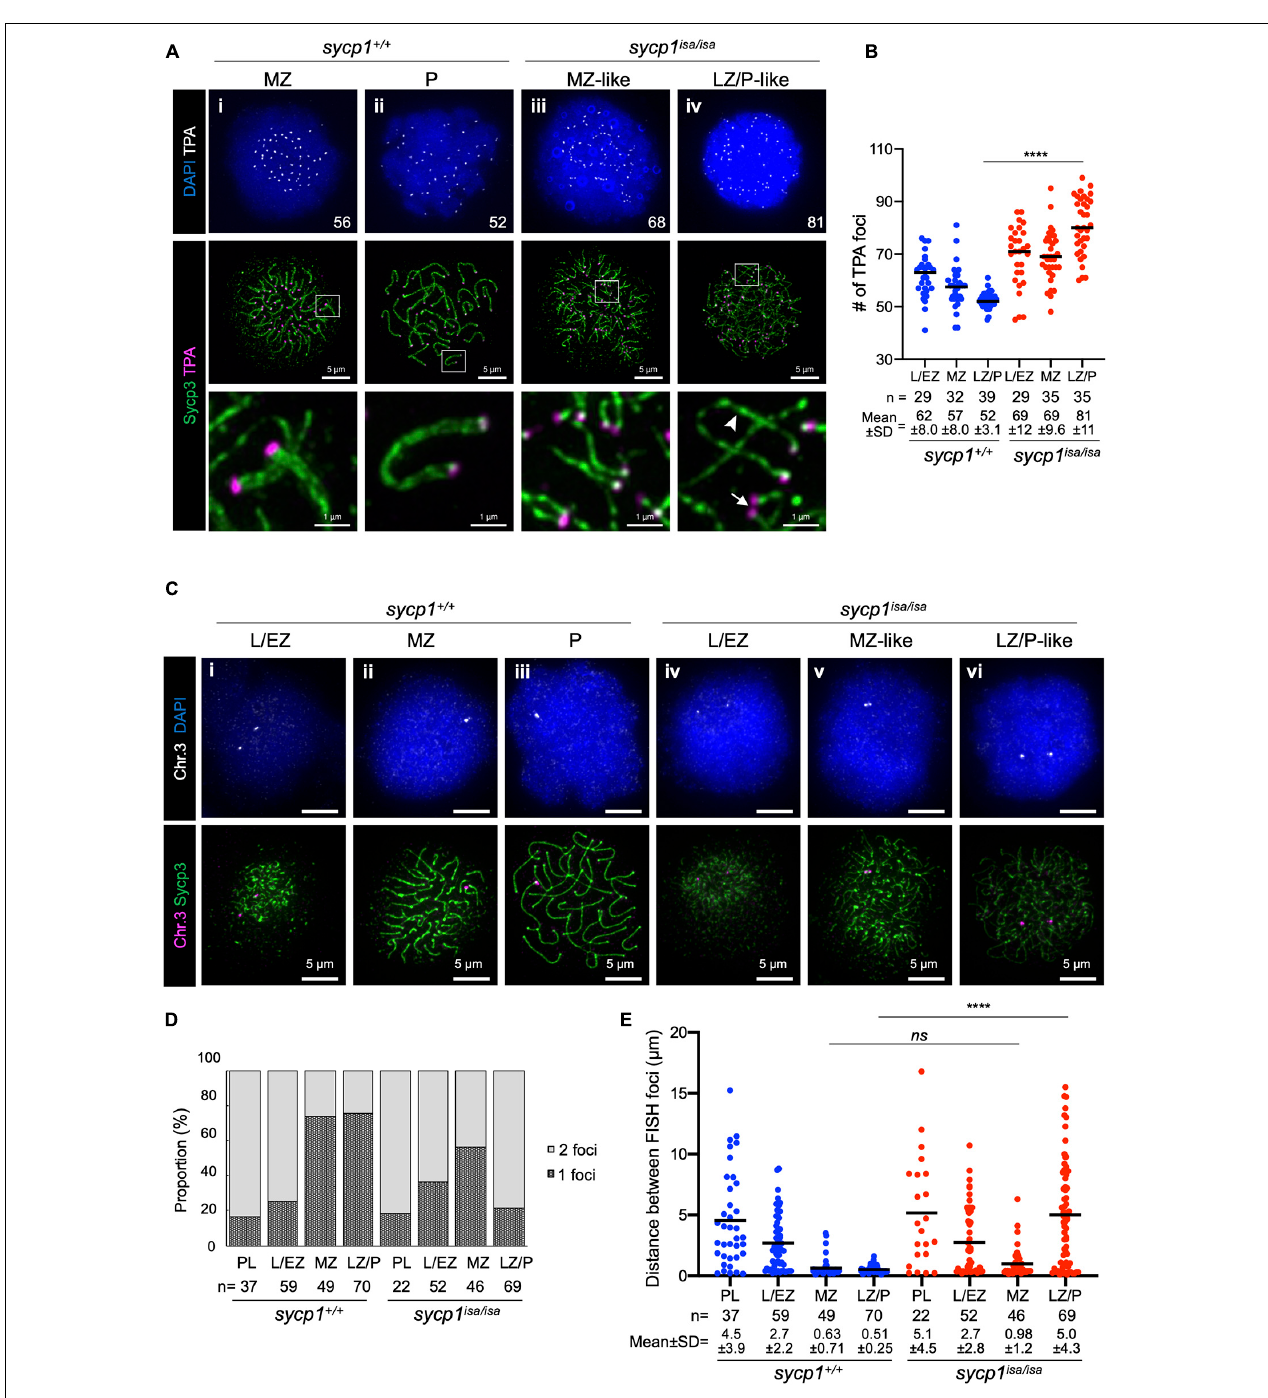
FIGURE 4 | Transient pairing of homologs at chromosome ends in sycp1 mutant spermatocytes. (A) costaining of telomeres (TPA) and Sycp3 in sycp1 + / + (i and ii) and sycp1 isa / isa (iii and iv) spermatocytes. The arrowhead indicates complete axis formation between two telomeres, and the arrow indicates paired telomere foci in LZ/P-like sycp1 isa / isa spermatocytes. Numbers in the top panels indicate counts of TPA foci. Regions indicated in white rectangles are shown at a higher magnification at the bottom. (B) quantification of telomere polyamide (TPA) foci in sycp1 + / + and sycp1 isa / isa spermatocytes. Black bars indicate means. Statistical significance was examined by a two-tailed Mann-Whitney test (**** P < 0.0001; exact P value). (C) fish staining of a peritelomeric locus on chromosome 3 in sycp1 + / + (i to iii) and sycp1 isa / isa (iv to vi) spermatocytes. (D) Proportion of nuclei with one or two FISH foci in sycp1 + / + and sycp1 isa / isa spermatocytes. (E) quantification of distances between FISH foci of a peritelomeric locus on chromosome 3 in sycp1 + / + and sycp1 isa / isa spermatocytes. Distances between FISH foci observed in Figure 4D . For nuclei with only one FISH focus, the radius of the FISH-stained area was considered the distance between two FISH foci. Black bars indicate means. Statistical significance was examined by a two-tailed Mann-Whitney test (**** P < 0.0001, ns, not significant; exact P value).